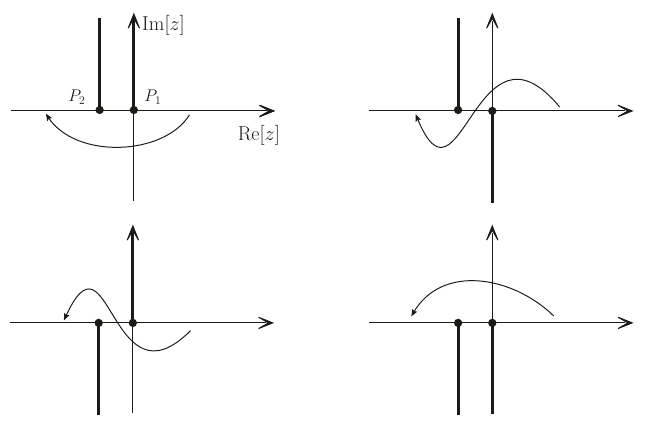
Figure 15 . Average continuation with more branch